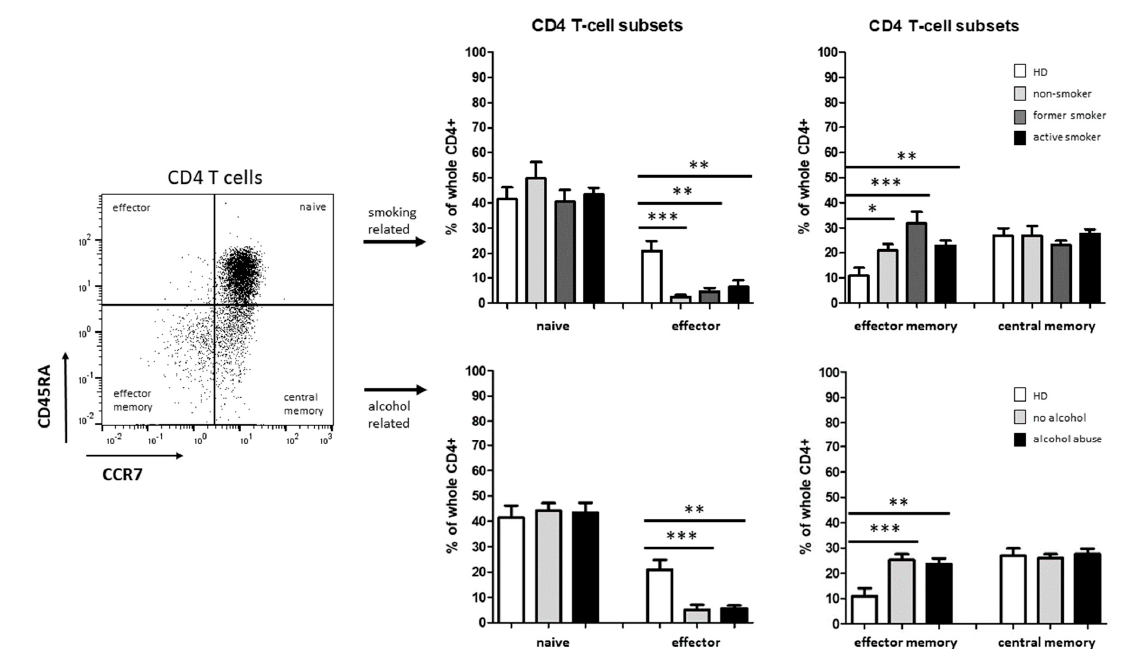
Figure 4. Correlation analysis between monocytic CD11b and CX3CR1 expression of HNSCC patients revealed a highly significant negative correlation in the analyzed ( A ) classical monocytes, ( B ) intermediate monocytes and ( C ) non-classical monocytes. A multivariate progression with the Pearson correlation was performed. The correlation coefficient (r) and p -values are given for each monocyte subset. p < 0.05 was considered as significant.